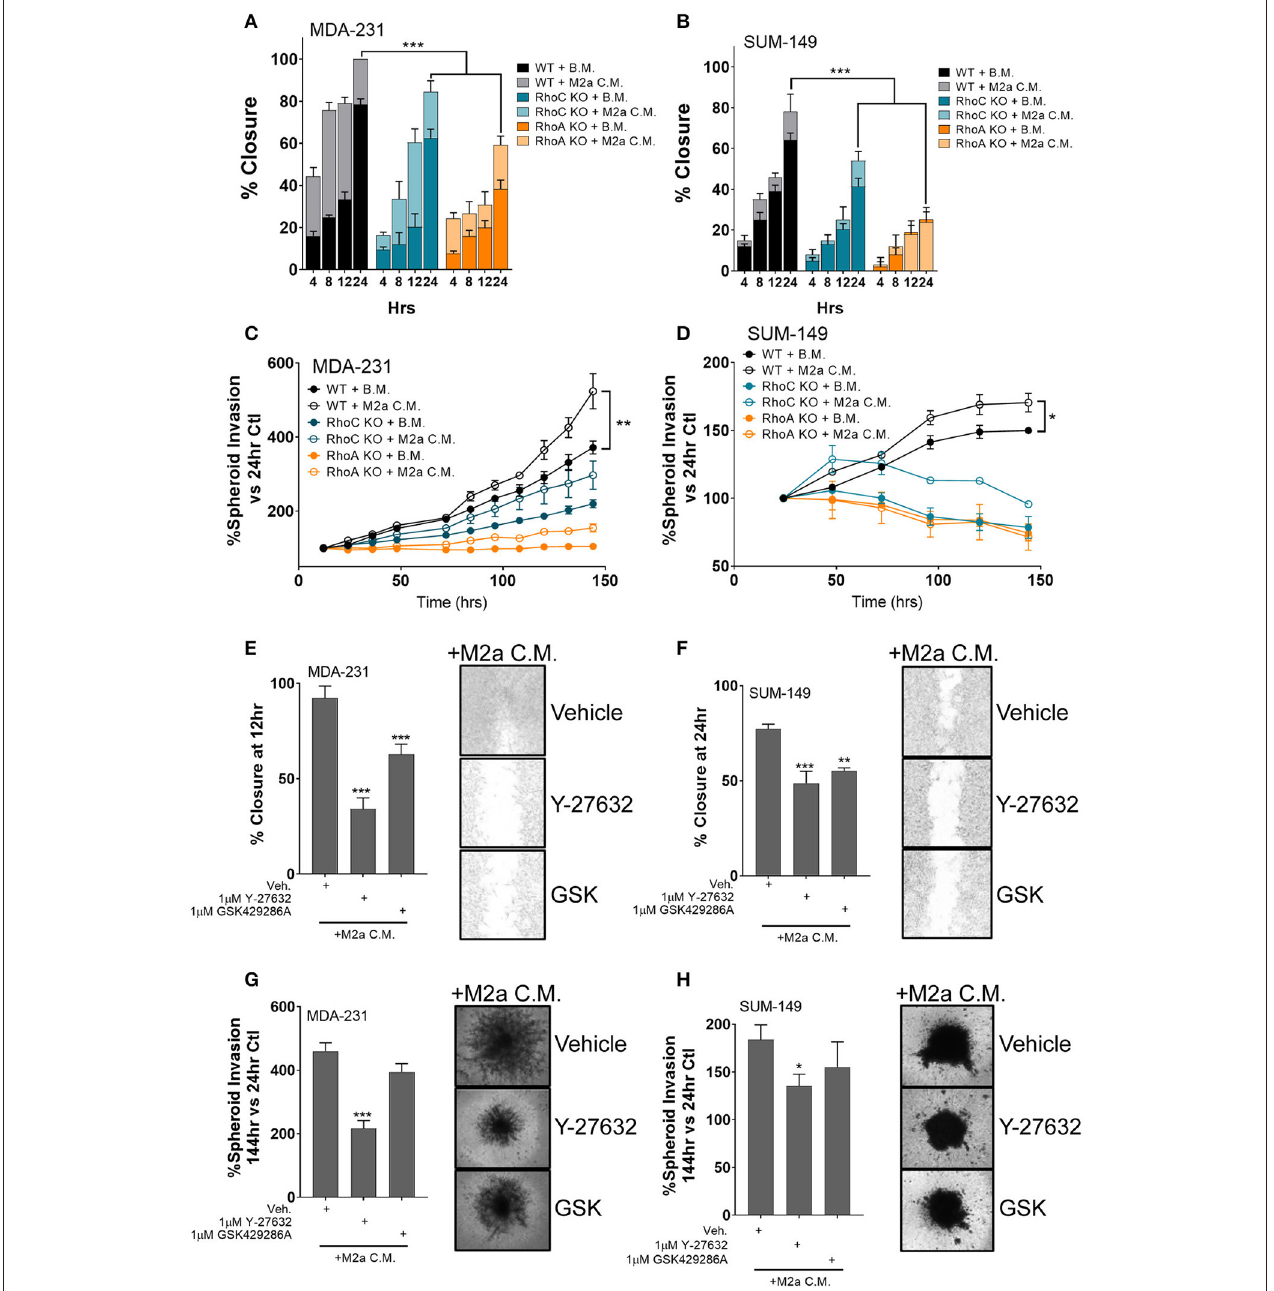
FIGURE 3 | The Rho-GTPases regulate migratory responses to M2a macrophage conditioned media. Scratch assays results display a reduction in M2a-induced migration in both MDA-MB-231 (A) and SUM-149 cells (B) . Similar results obtained from 3D spheroid invasion assays (C: MDA-231; D: SUM-149) . Pretreatment with 1 µ M ROCK inhibitor (either Y-27632 or GSK429286A e.g. “GSK”) reduces M2a macrophage-induced 2D migration or 3D spheroid invasion in both MDA-231 (E,G) and SUM-149 cells (F,H) . All results are compiled from ≥ 2 independent experiments; error bars represent ± standard deviation; p -value is displayed as * p < 0.05, ** p < 0.01, *** p <